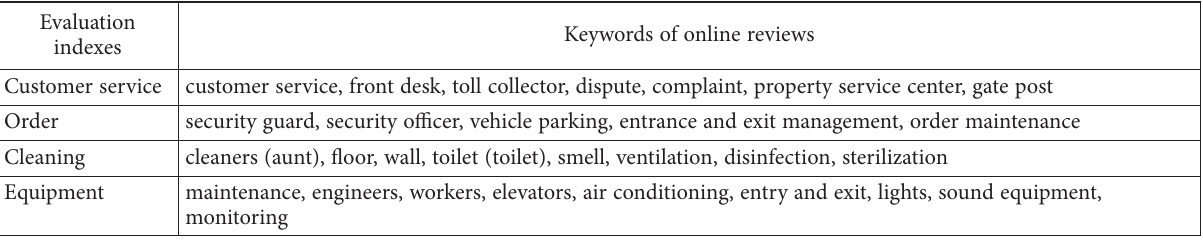
Table 2. Evaluation index classification of online reviews of public property service quality Evaluation indexes